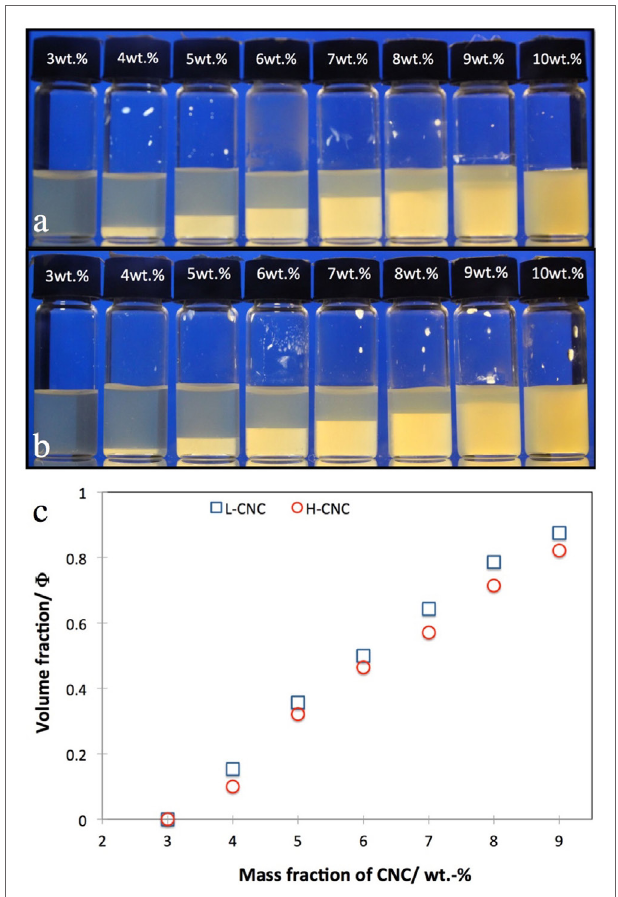
FigUre 4 | effect of nacl addition on the macroscopic volume fraction Φ of n* phase at different cnc concentrations for (a) l-cnc and (B) h-cnc .